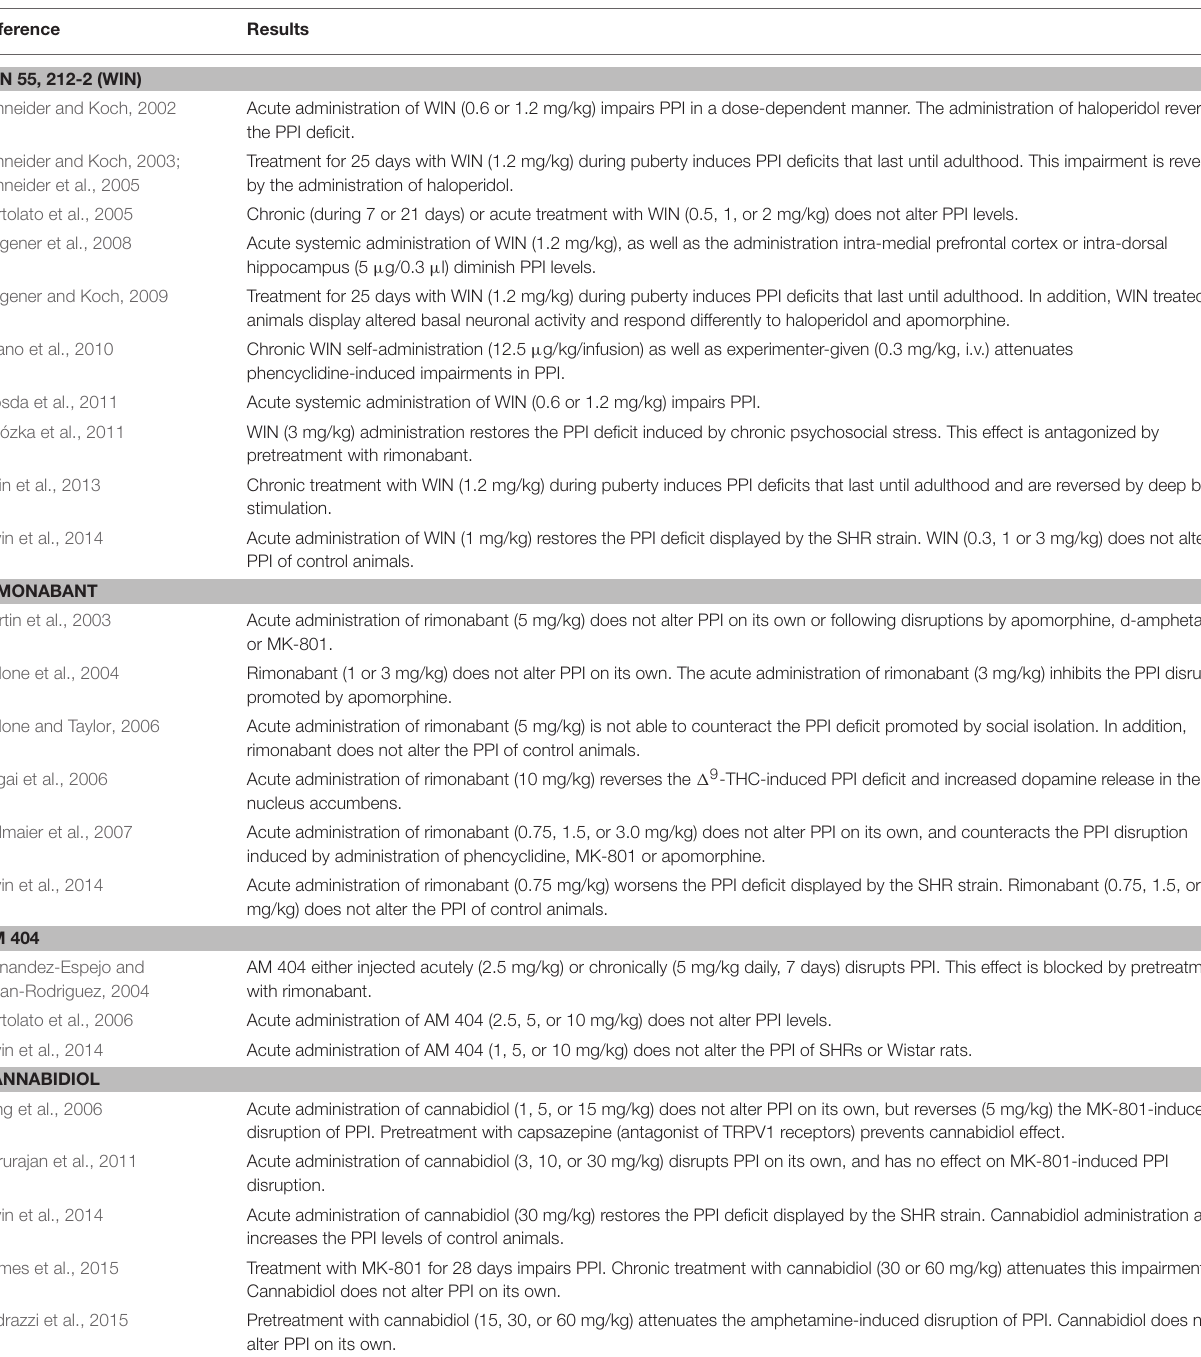
TABLE 2 | Summary of the studies investigating the effects of cannabinoid drugs on the PPI of animal